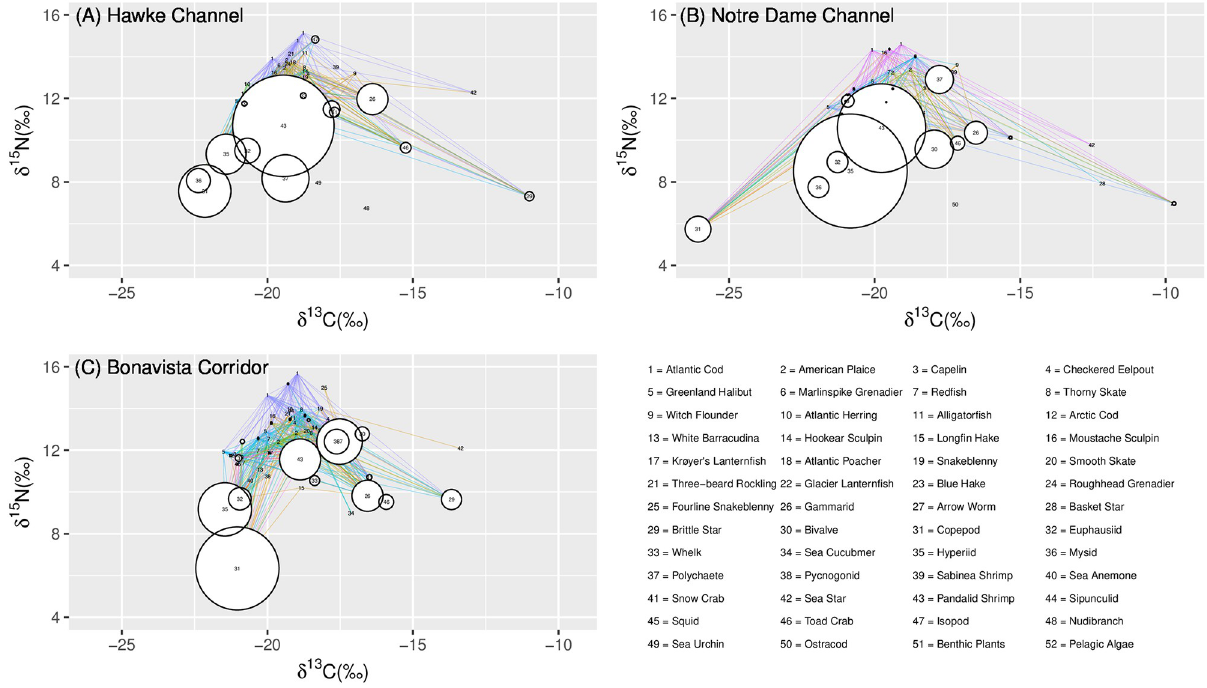
Fig 3. Simplified food webs with line widths indicating the linkage strength of the predatory interaction for (A) the Hawke Channel, (B) the Notre Dame Channel and (C) the Bonavista Corridor. Circles represent the relative linkage strength from the given prey species. Species from which a number of size classes were obtained will appear up to three times (for small, medium, and large size categories). Taxa abbreviations are defined in Table